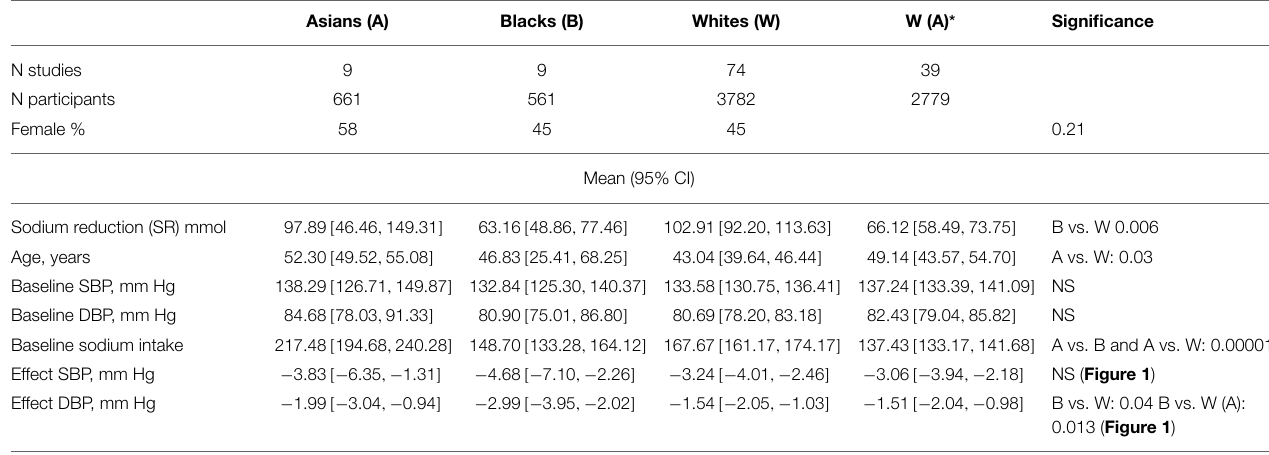
* Sodium reduction adjusted to Blacks by elimination of all studies of Whites with SR >